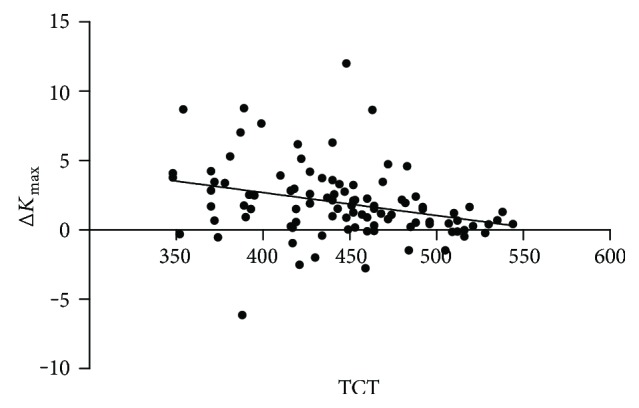
The scatter plot between TCT and ΔKmax after 12 months of treatment.